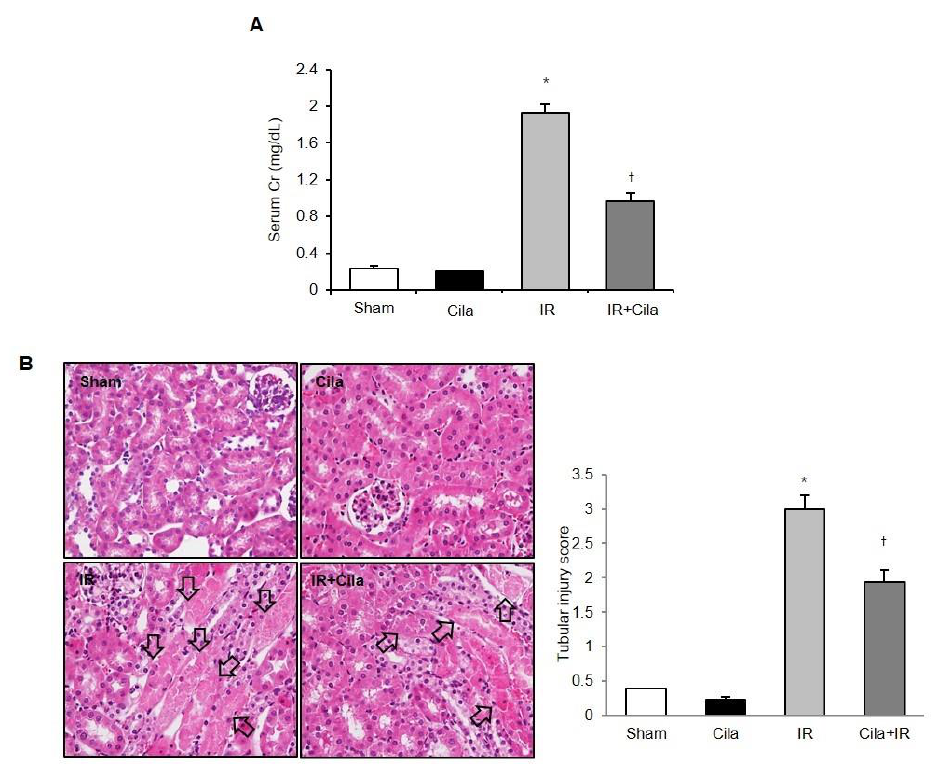
Figure 7. Cilastatin preconditioning improved renal function and tubular necrosis in mouse kidney with IR injury. ( A ) Serum creatinine levels were significantly increased at 24 h after IR injury compared with serum creatinine levels in sham-operated mice. Cilastatin pretreatment improved serum creatinine level in mouse kidney with IR injury. ( B ) The representative staining with hematoxylin and eosin showed a decreased tubular necrosis (arrows) in the cilastatin-treated mouse kidney with IR injury compared with mouse kidney with IR injury not treated with cilastatin (original magnification, × 200). The data are presented as means ± SEM. * p < 0.05 vs. sham and Cila group; † p < 0.05 vs. IR group.